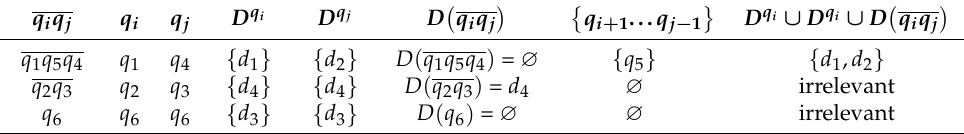
Table 3. Computation of nearest neighbor Q (cid:111)(cid:110) D using the SCL